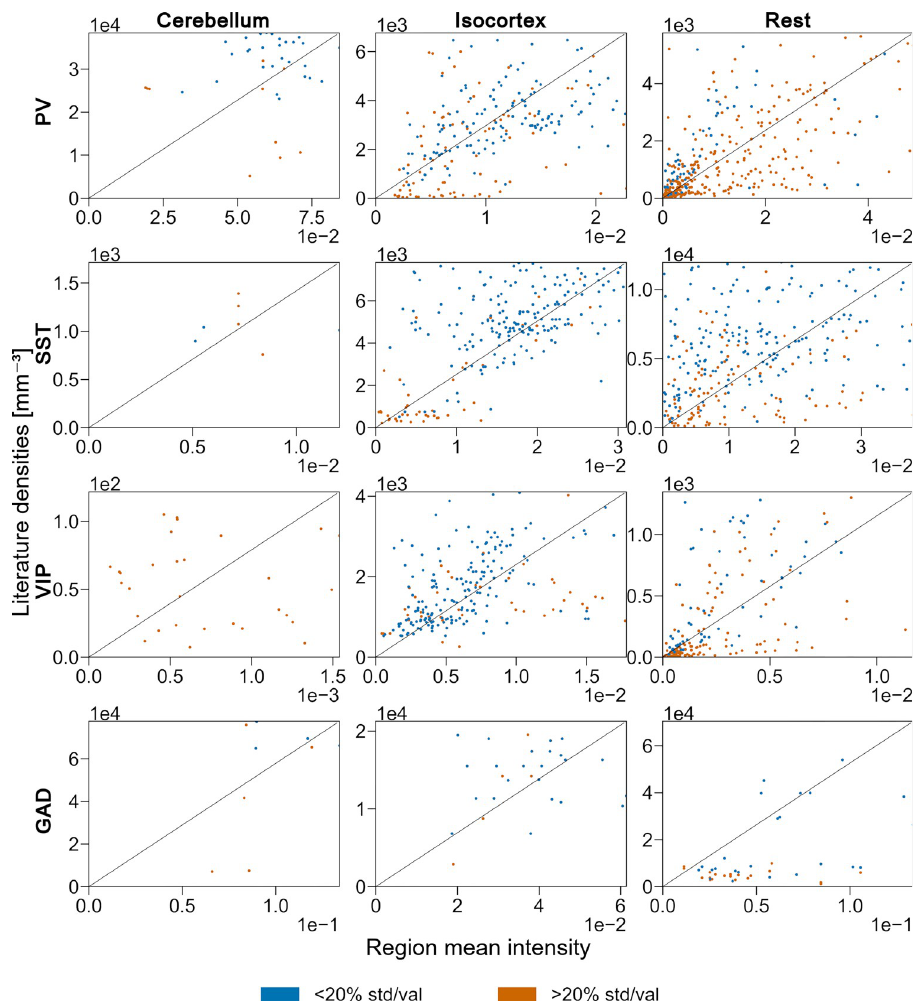
Fig 5. Linear fitting of marker intensity to cell density in cerebellum, isocortex, and the rest of the brain. Scatter plots of the PV+, SST+, VIP+ and GAD+ densities reported in literature (y-axis) according to the region mean intensity (x-axis) grouped by the main regions of the brain, respectively cerebellum, isocortex, and the rest of the brain. Each point represents a single literature density value and is color-coded according to the different levels of confidence (ratio of standard deviation over mean value) from literature data. The linear fit is represented with a black diagonal line. Each panel shows 95% of the available points. Regions that are purely inhibitory (i.e., based solely on the neuron counts obtained at step 2 of the pipeline), with no inhibitory neurons and regions with null region mean intensity are not displayed and were not considered for the